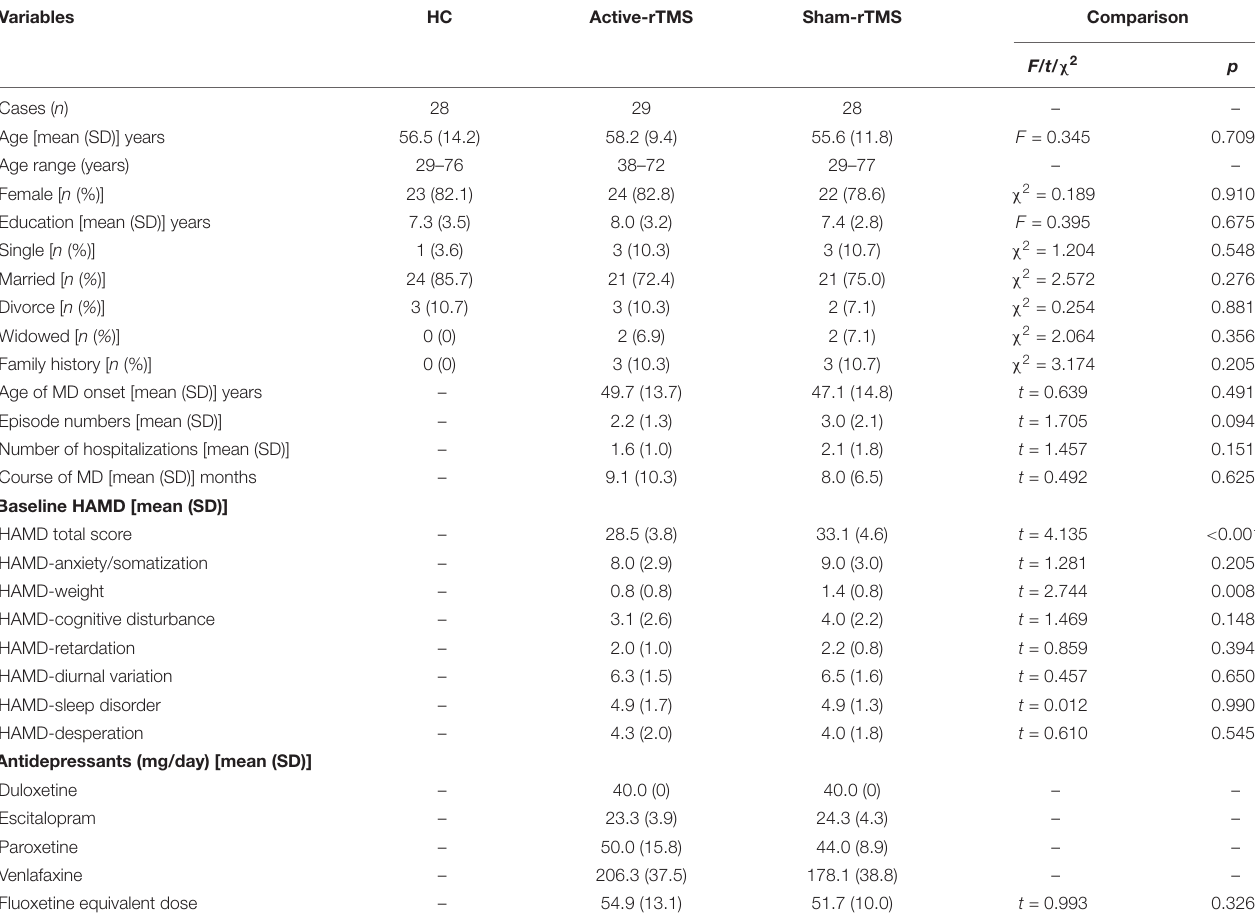
TABLE 1 | Demographic and clinical variables, comparison among healthy controls (HC), active-rTMS, and sham-rTMS